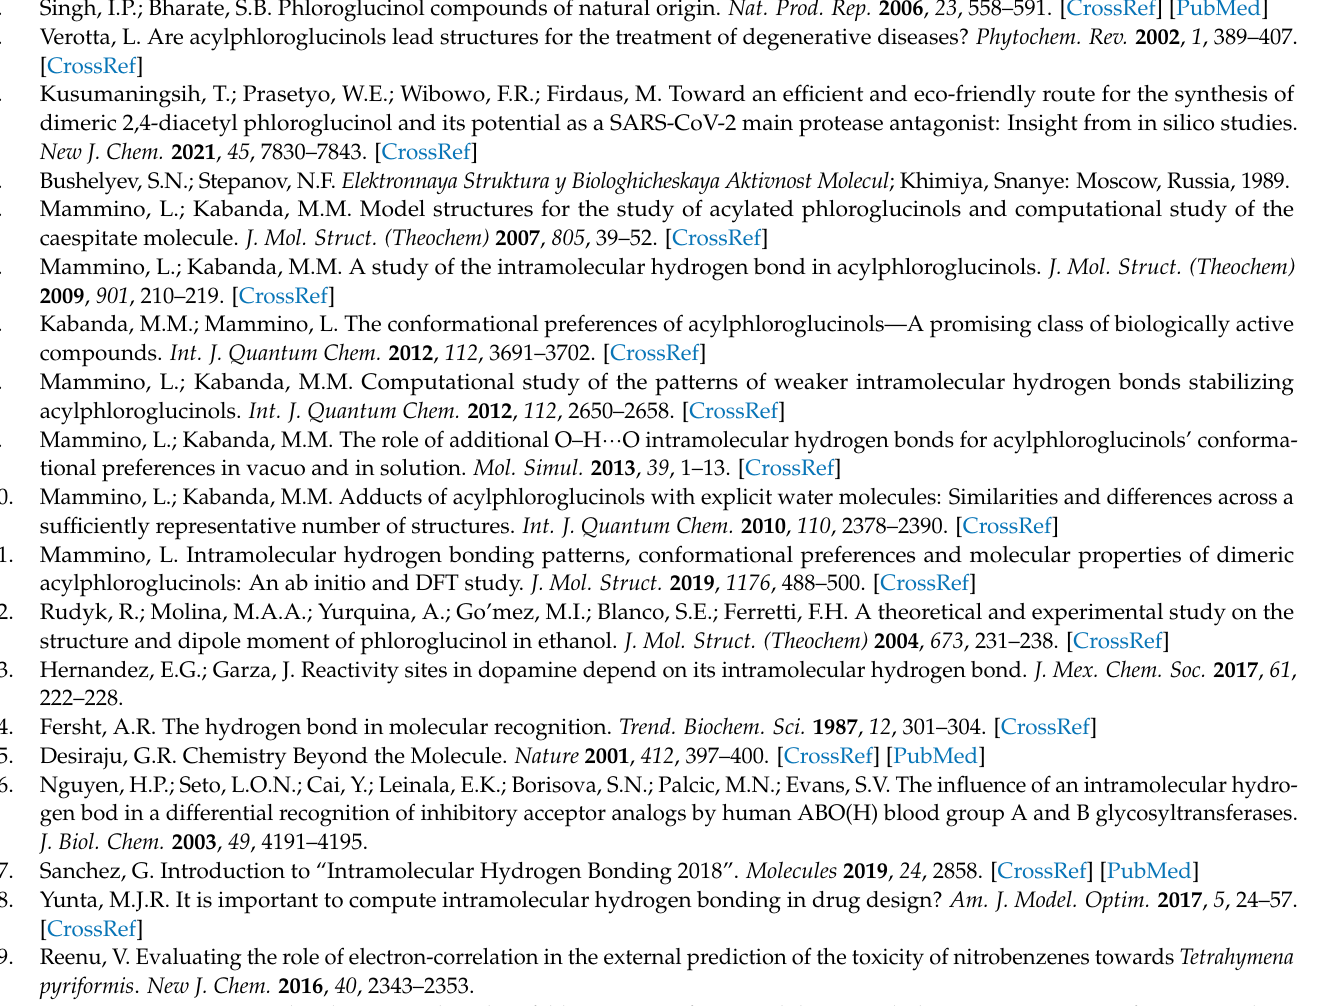
Table S19: Information from the obtained MP2 results for trimeric